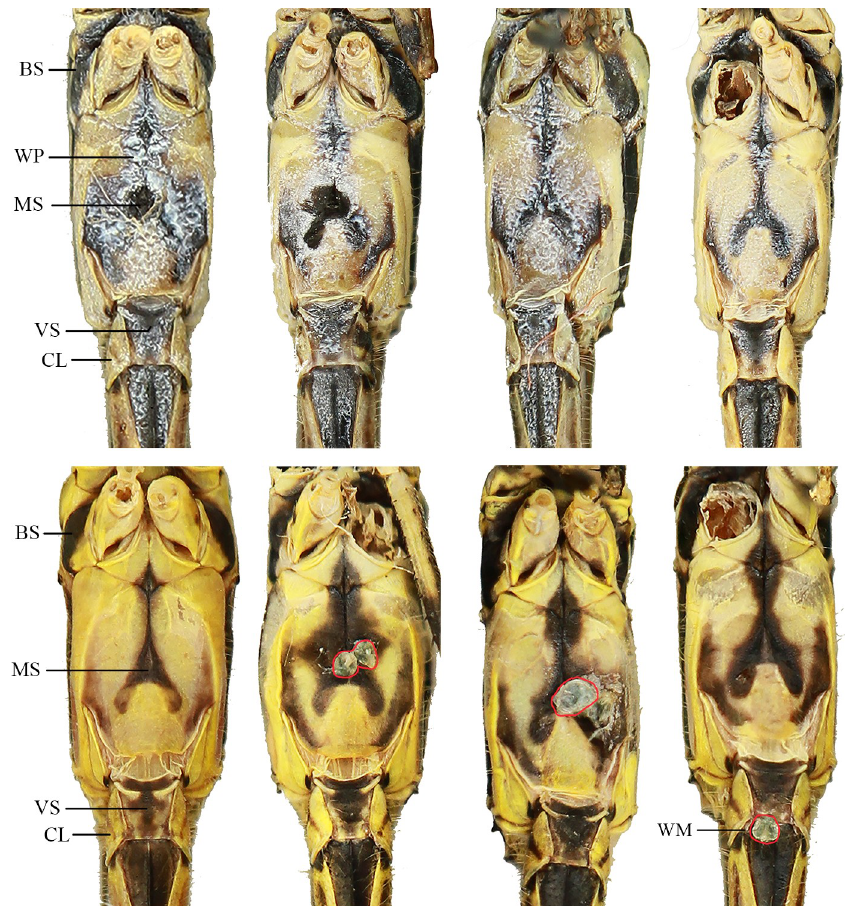
Fig 4. Coloration similarities between Franciscobasis sonia (below) and F . franciscoi (above). BS: Black stripe; WP: White pruinosity; MS: Midventral black stripe; VS: Dark ventral spot; CL: Circle oblique dark line; WM: Water mites.